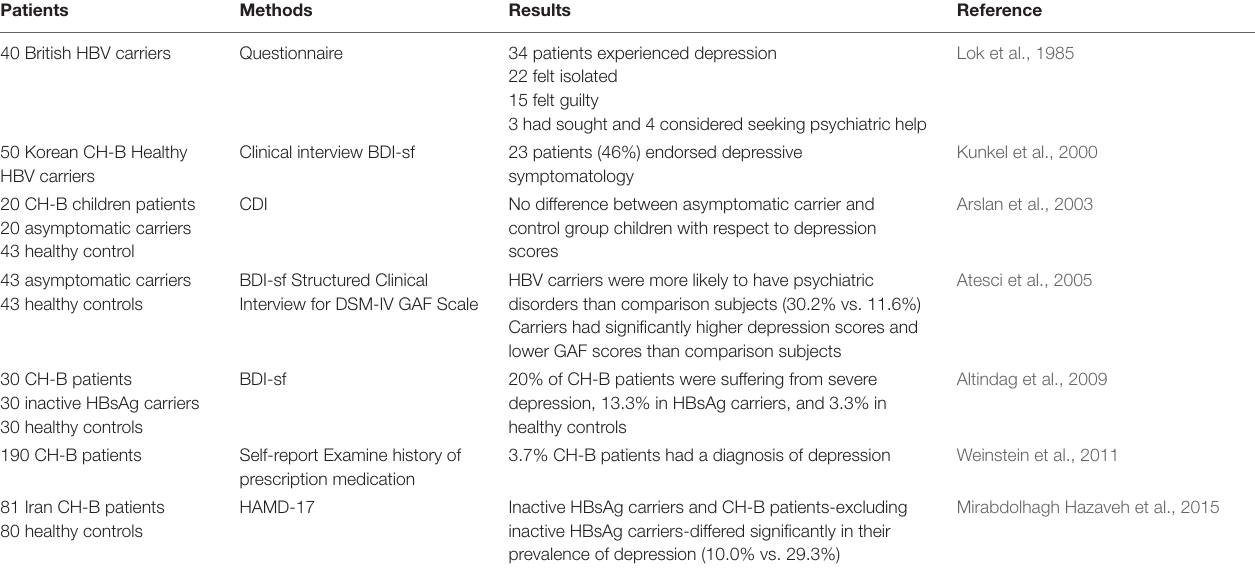
TABLE 1 | The prevalence of depression in patients with CH-B. Patients Methods